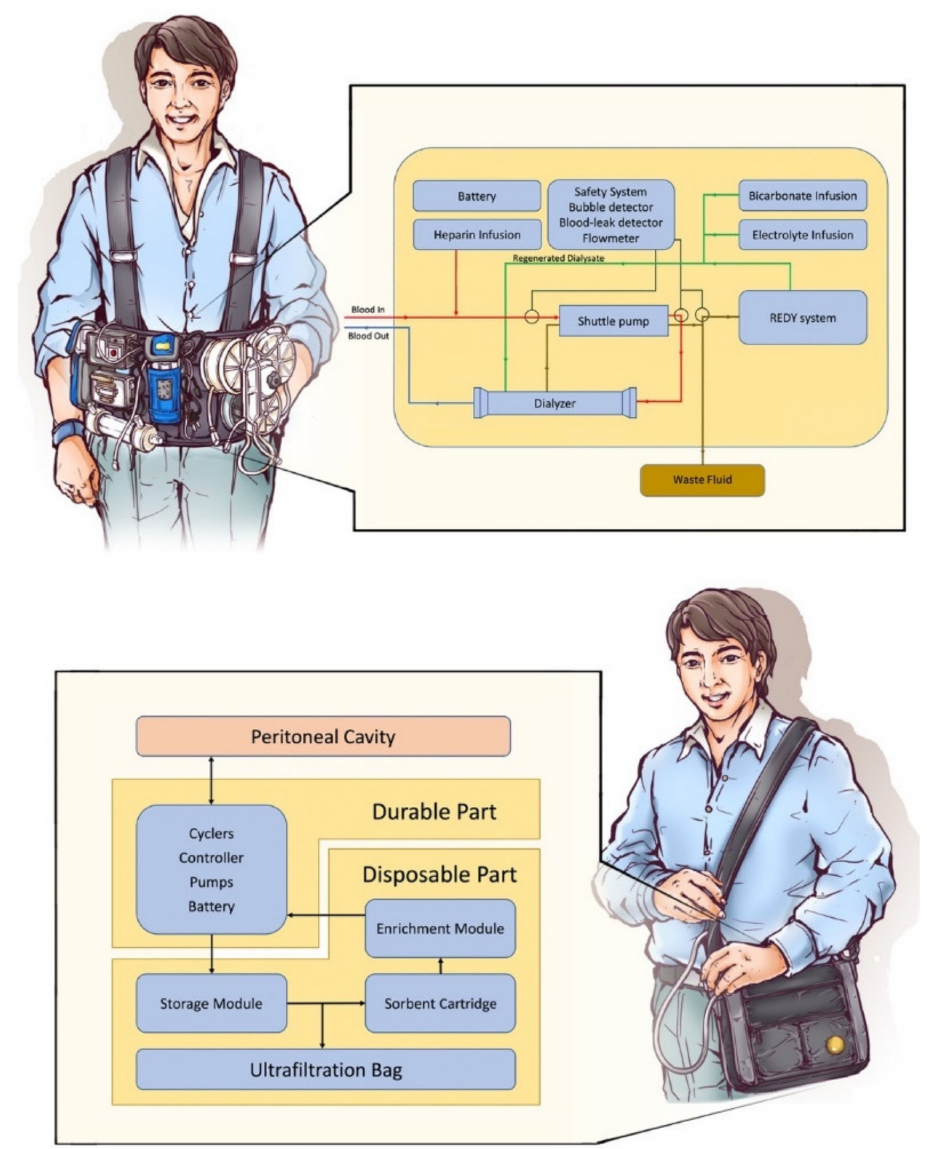
Figure 3. Basic concepts of a wearable hemodialyzer and a peritoneal-based wearable artificial kidney: within a wearable hemodialyzer (upper), the pumps, battery, safety system, and REDY system are all installed in a vest. During dialysis, the REDY system regenerates dialysate and reduces the requirement of water. A bubble detector, blood leak detector, and flowmeter monitor all fluid compartments and shut off the system in the case of an emergent condition. The peritoneal-based wearable artificial kidney (lower) is connected to the patient’s peritoneal cavity and regenerates dialysate fluid. The disposable part of the device is exchanged after